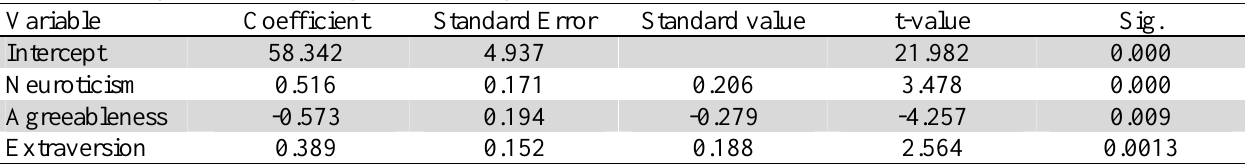
The summary of stepwise regression analysis